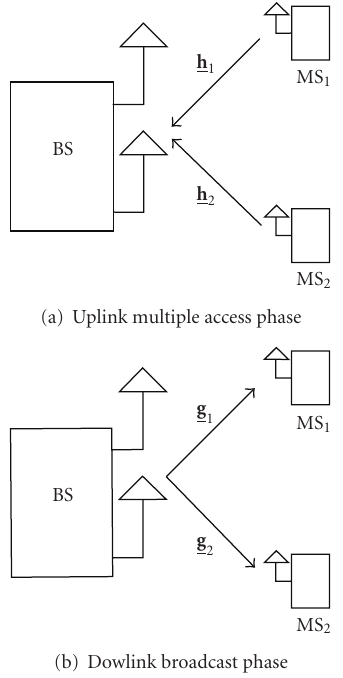
Figure 2: Block diagram of the system